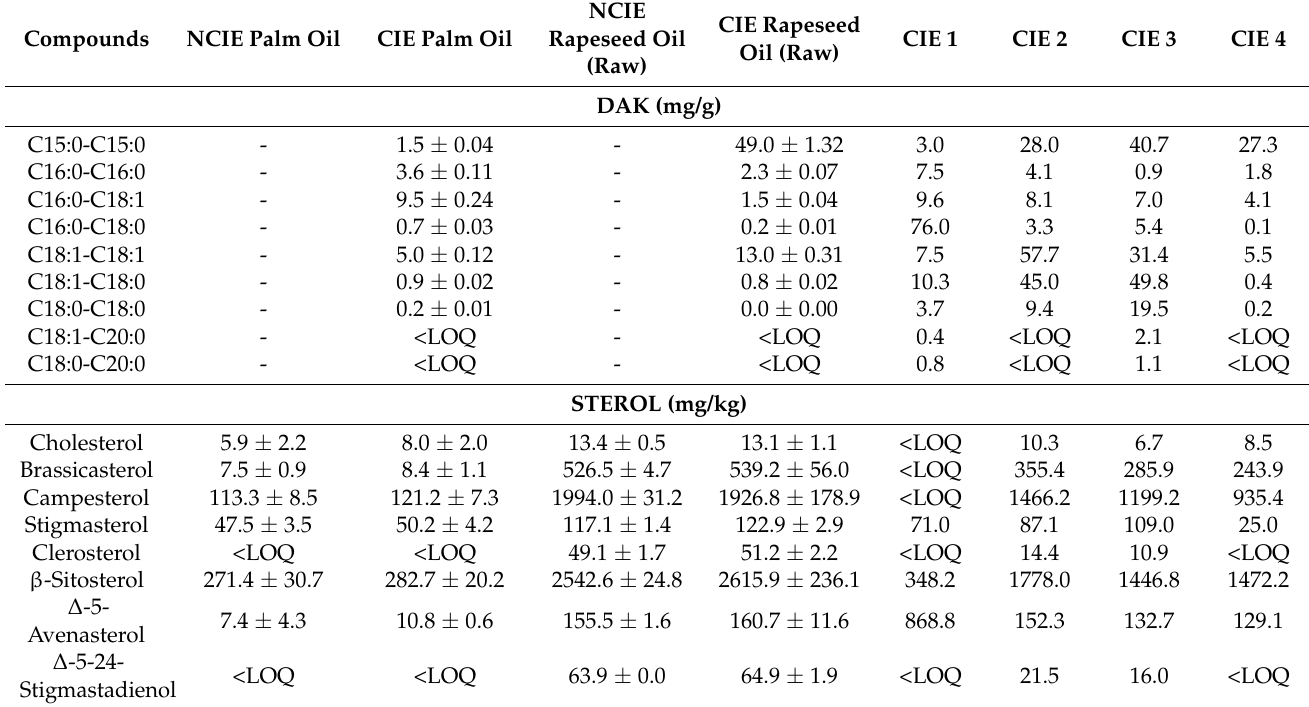
Table 3. DAK and sterol composition of no chemically interesterified (NCIE) and chemically interesterified (CIE) palm oil, NCIE and CIE rapeseed oil, CIE shea butter, CIE mix of raw and hydrogenated rapeseed oil (70/30 and 60/40), CIE mix of rapeseed and palm